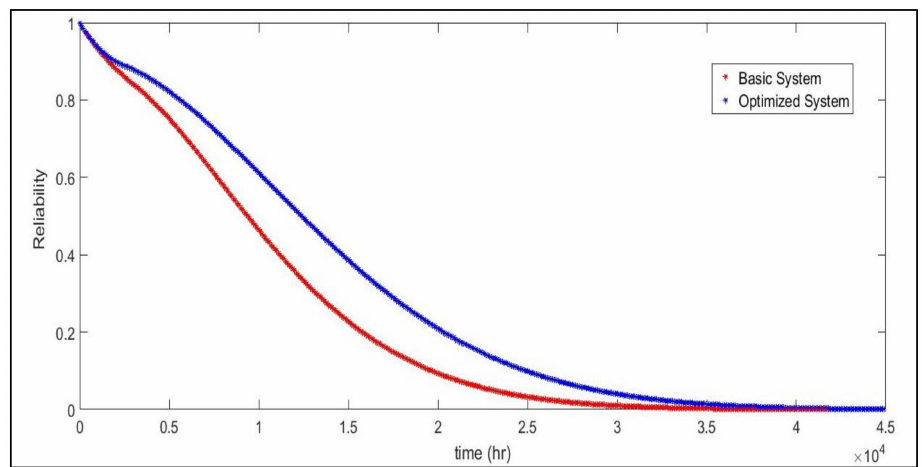
Figure 8. Reliability profile of the complete system, unit A and system without redundant unit. Eventually, the MTTF and median time for the optimized system were calculated, and 29% and 32% increases were observed in results compared to the basic